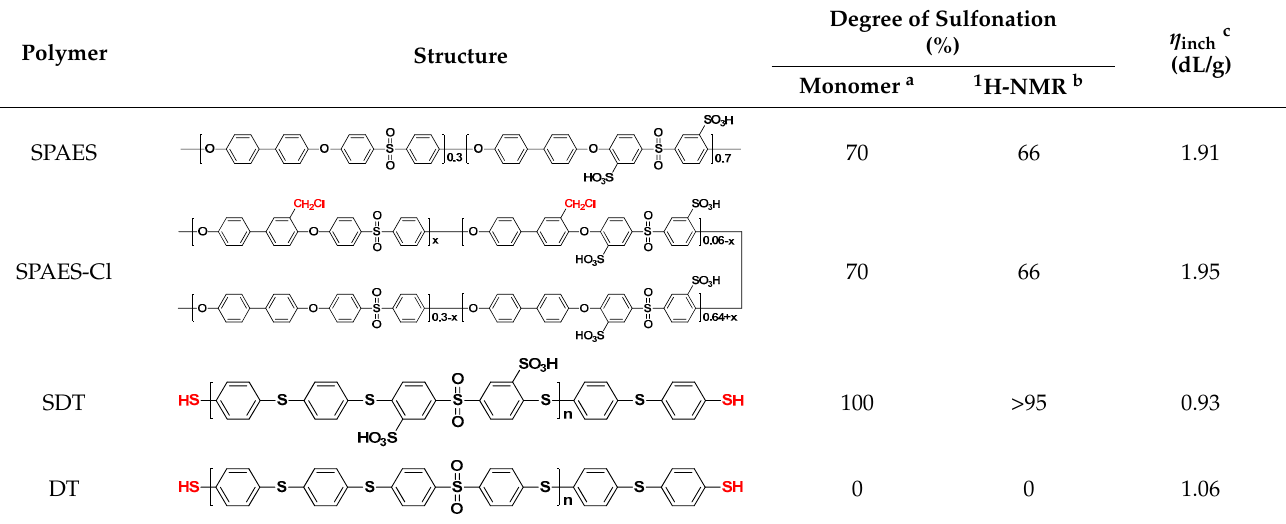
Table 1. Degree of sulfonation values and inherent viscosity of SPAES, SPAES-Cl, SDT and DT.